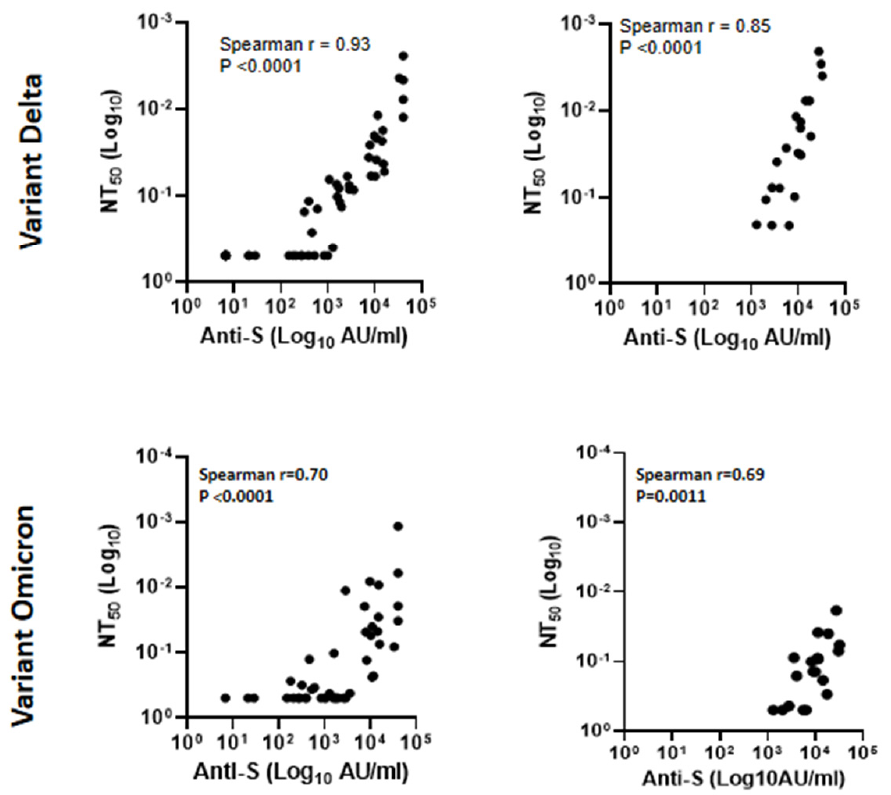
Figure 4. Relationship between serum neutralization titers in cell culture and the amounts of anti- S-RBD antibodies detected in the same sera from individuals in the ImmunoSupp-V (double- or triple-BNT162b2 vaccinated immunocompromised allogeneic HSCT recipients) and ImmunoComp-V (double-BNT162b2 vaccinated healthy immunocompetent individuals) groups. Anti-S-RBD titers were plotted against the corresponding NT 50 for variants D614G, Beta, Delta, and Omicron BA.1. Correlations between NT 50 and anti-S-RBD titers were calculated using Spearman’s correlation, and p -values are indicated for each graph.